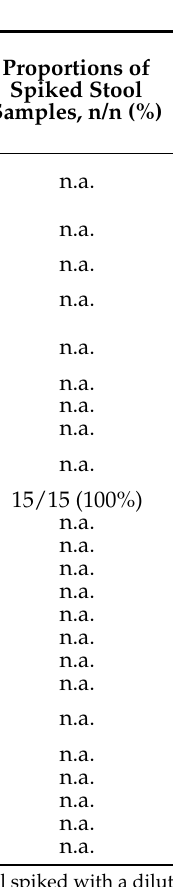
Table 2. Results of the assessments with weakly positive samples. Calculated sensitivity values refer to the applied reference standards as described in the Methods